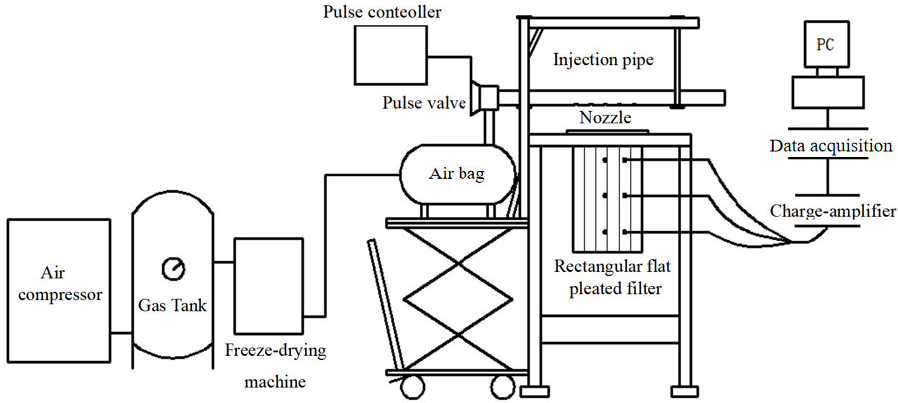
Figure 2. Schematic diagram of the pulse ‐ jet experimental